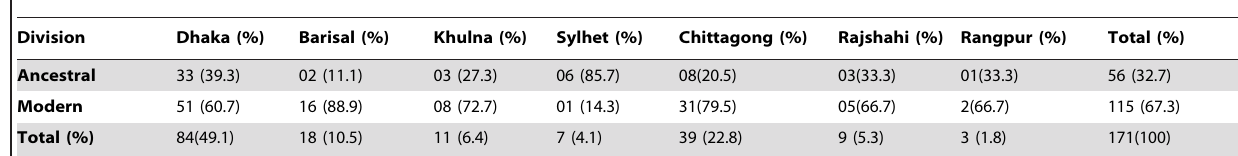
Table 1. Distribution of ‘ancestral’ and ‘modern’ M. tuberculosis strains within